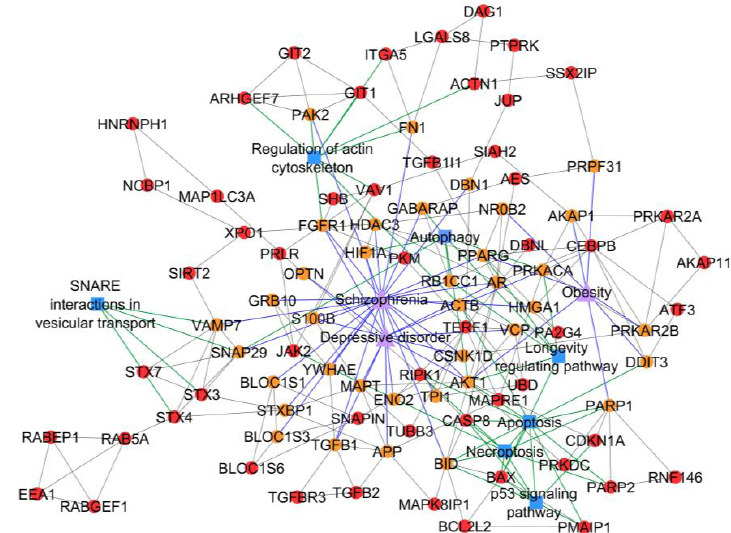
Figure 4. PCOS–disease subnetwork 26. Shared proteins and shared pathway (antigen processing and presentation) between PCOS and schizophrenia were identified from this subnetwork. Different coloring of nodes and lines represents PCOS-related proteins (red), shared proteins (orange), PCOS–disease interactions (blue), and protein–pathway interactions (green). Shape of nodes denotes PCOS-related proteins (circle), disease (triangle), and pathway (square).